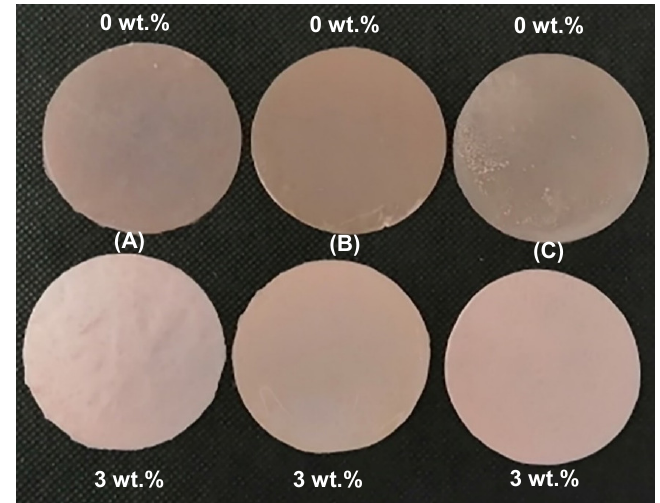
Figure 4. Bar chart demonstrating the mean solubility values of specimens after immersing for 180 days in distilled water and artificial saliva. Materials 2020 , 13 , x FOR PEER REVIEW